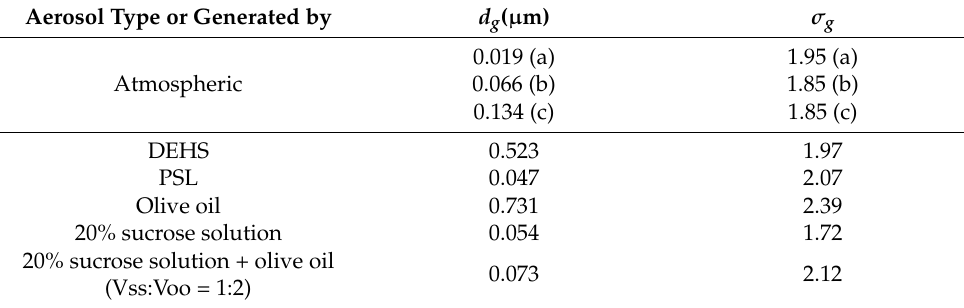
Table 1. Size distribution parameters of aerosols measured. Aerosol Type or Generated